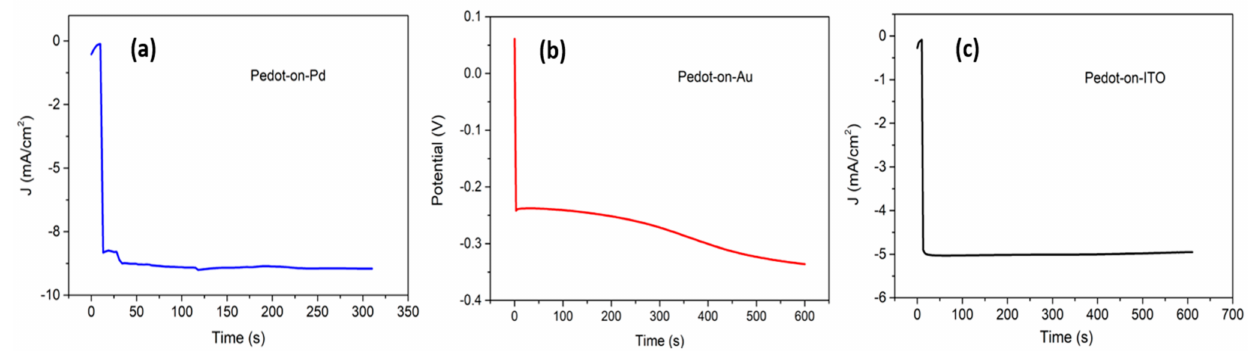
Figure 5. Curves of the copper deposition on three different working electrodes: ( a ) PEDOT/Pd, ( b ) PEDOT/Au, ( c ) PE- DOT/ITO. The electrodepositions were accomplished in a one-compartment, three-electrode electrochemical cell, with Pt wire as the counter electrode and an Ag wire as the reference